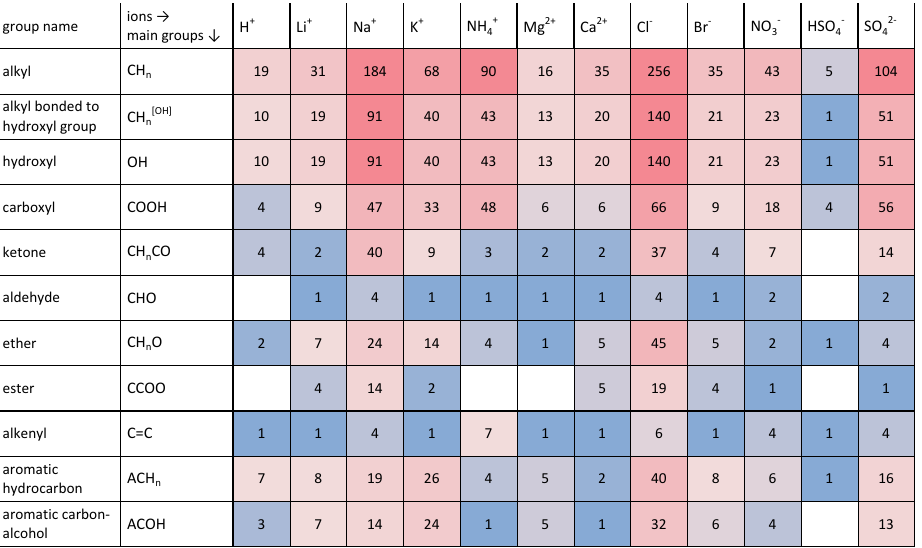
Fig. 8. Distribution of datasets for the determination of organic main group ↔ ion interaction parameters. The number of different datasets associated with each interaction pair is shown. Percentile-wise coloring based on the number of datasets suggests the degree of confidence (based only on statistical considerations) in the determined interaction parameters: blue (low confidence) to red (high confidence). Main group CH n represents here also the specific alkyl main groups CH